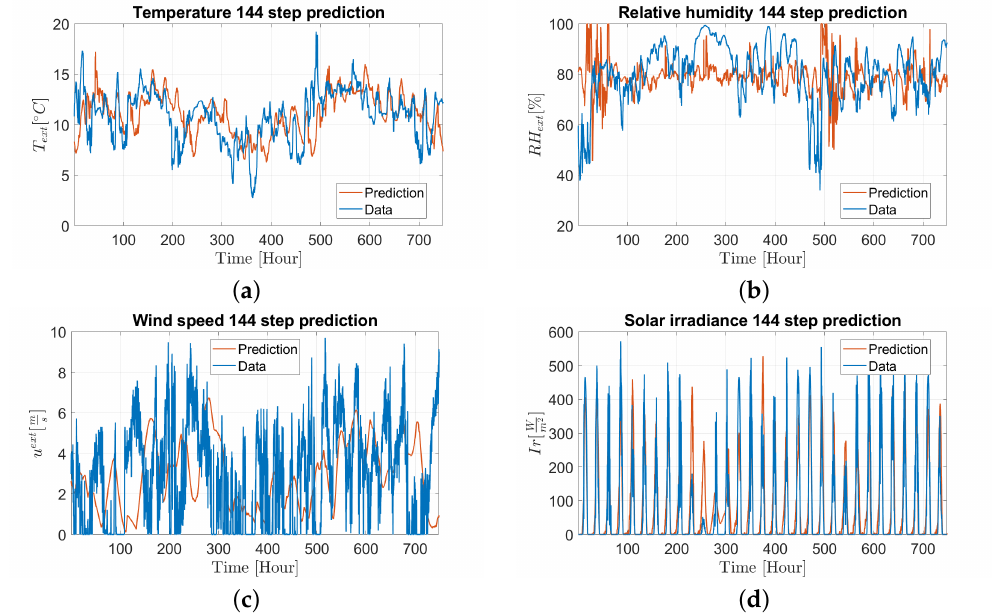
Figure 4. One-day predictions of all the climate variables considered for short-term climate prediction in the greenhouse. In each graph, the blue line represents the real data measured at the greenhouse, and the red line shows the corresponding model output. ( a ) Temperature outside the greenhouse T ext ;